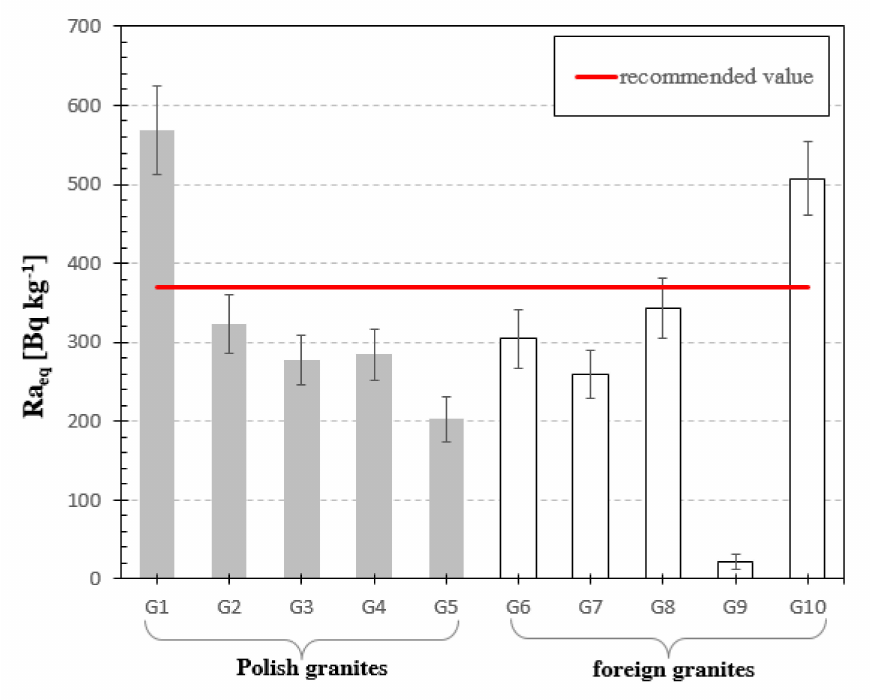
Figure 8. Radium Equivalent Activity in analyzed granite samples. The horizonal line indicates the recommended value of Ra eq equal to 370 Bq / kg [23] for natural